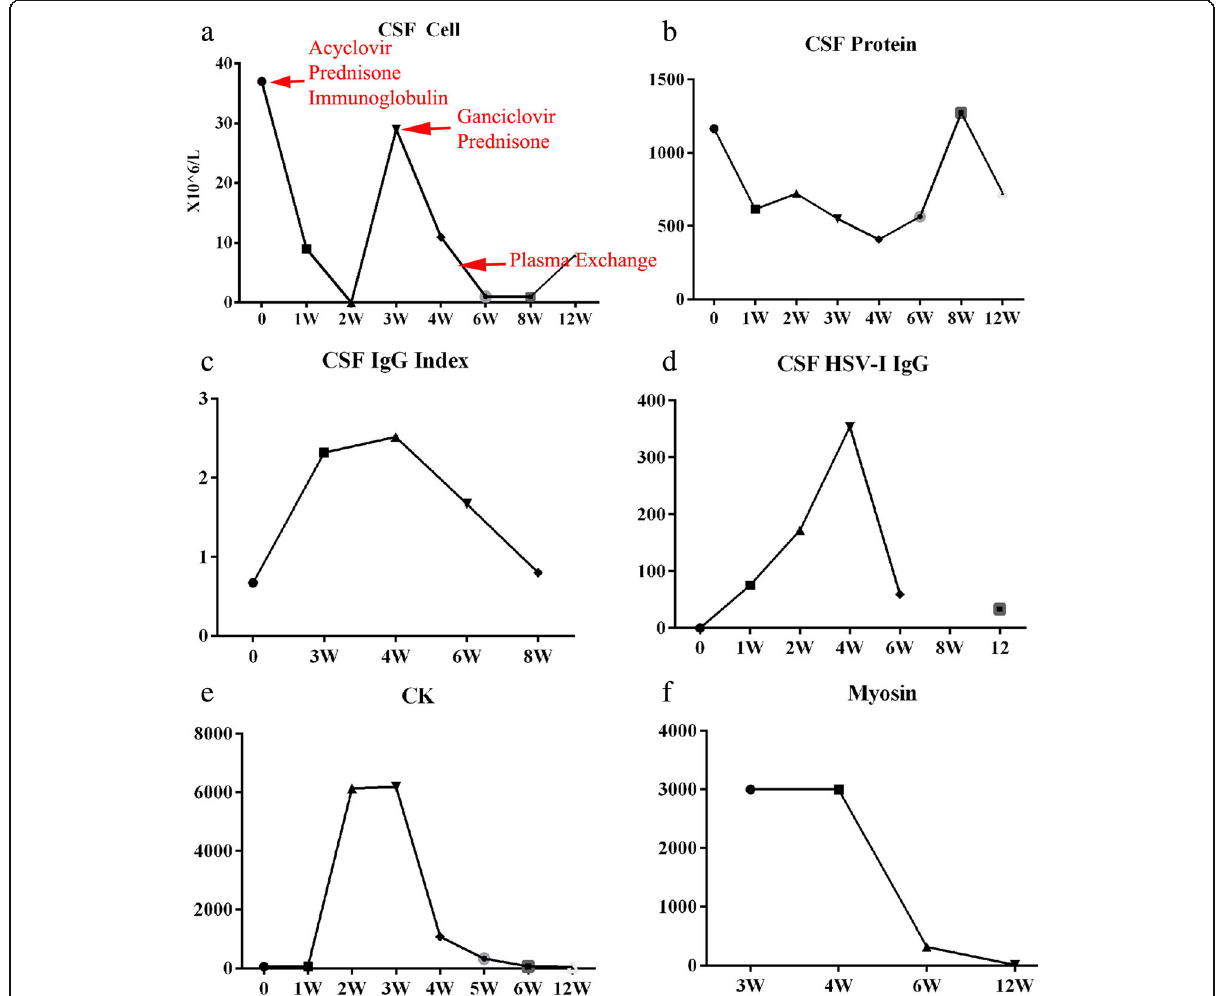
Fig. 1 Dynamic alterations of CSF and blood biochemical indexes during treatment. a On the first day of admission, CSF cells were increased. After two weeks of treatment with acyclovir, hormone shock therapy and immunoglobulin shock therapy, the cell count was decreased to normal level. After 3 weeks of treatment, the cell count increased again. After repeated treatment with prednisone and ganciclovir, it gradually decreased to normal level. b On the first day of admission, the CSF protein content was increased, and then decreased slowly after treatment. c On the first day of admission, the CSF IgG index was increased progressively, peaked at 4 weeks after admission, and decreased gradually after treatment. d On the first day of admission, CSF HSV-1 IgG was increased progressively, peaked at 4 weeks after admission, and decreased gradually after treatment. e The level of blood CK increased 2 weeks after admission, was maintained at a high level in the following 1 week, and decreased to normal level in the following 2 weeks. f The level of urine myosin increased obviously 2 weeks after admission, was maintained at a high level in the following 1 week and decreased to normal level in the following 2